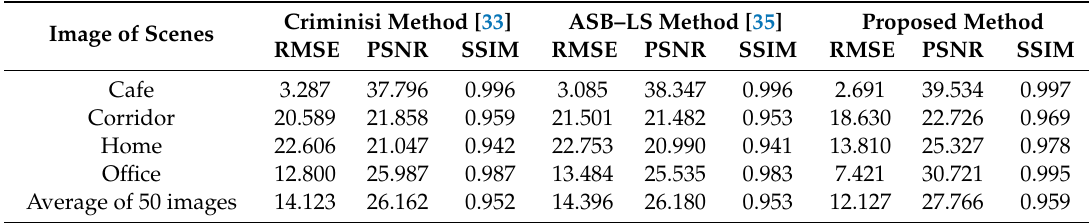
Table 1. Method comparison based on the ground-truth image with root mean square error (RMSE), peak signal-to-noise ratio (PSNR), and structural similarity index measure